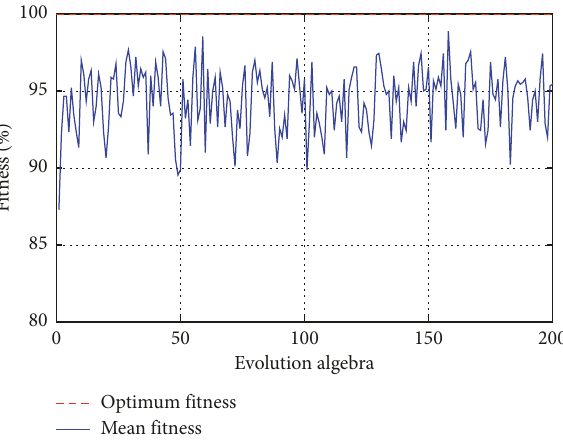
Figure 6: Experimental results of SVD values as eigenvalues.